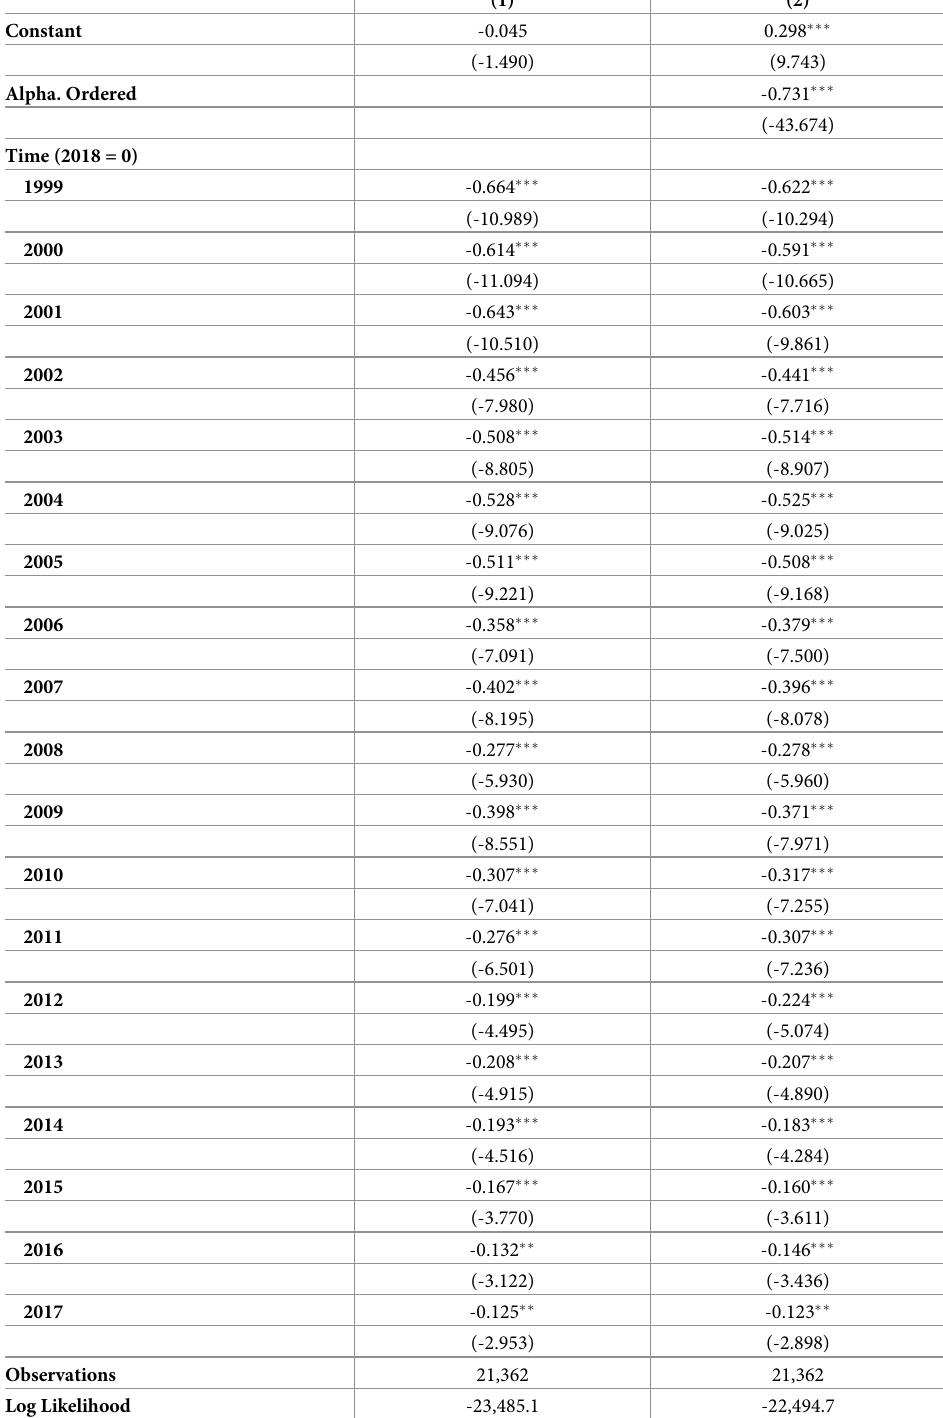
Table 3. Poisson regression: Dependent variable is number of article coauthors minus